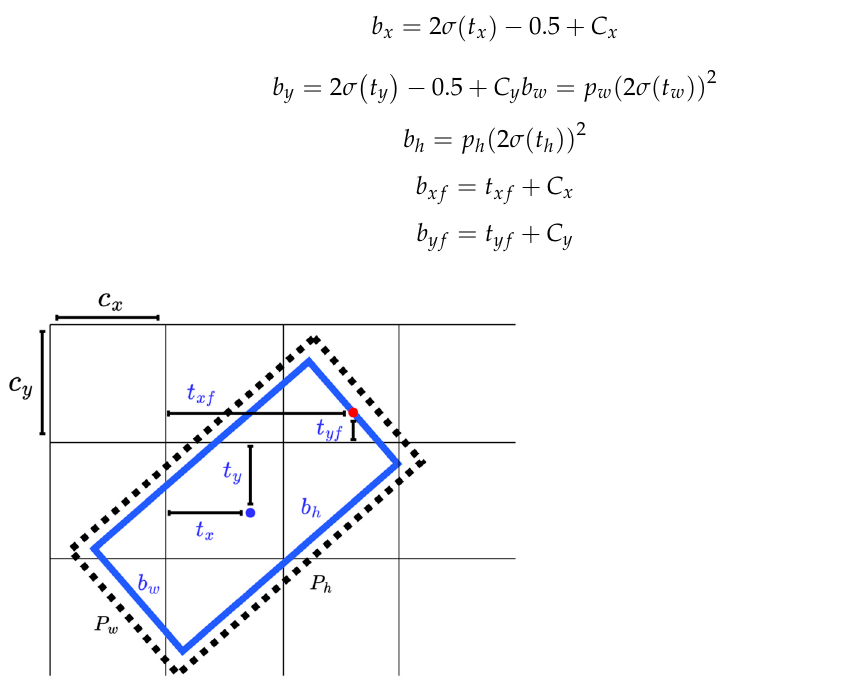
Figure 2. The network predicts 6 coordinates t x , t y , t w , t h , t xf and t yf of each bounding box. ( C x , C y ) is the cell offset from the top left corner of the image. Red point and blue point denote the front point and center point of bounding box, respectively. Both front point and center point share the same grid cell in the network.